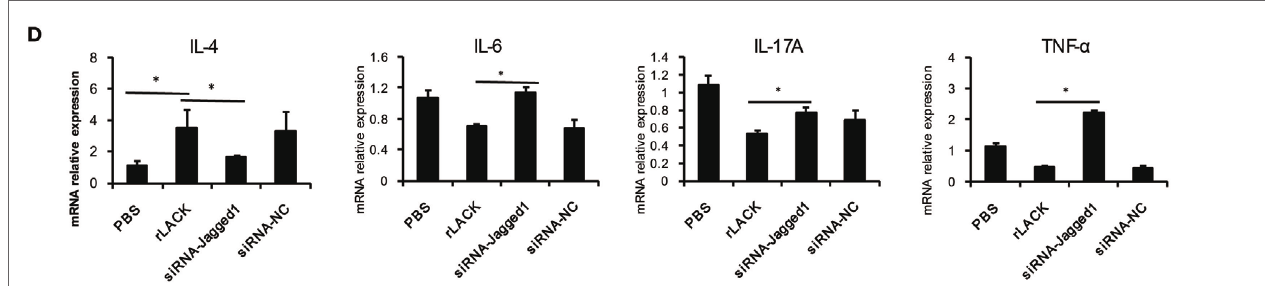
FigUre 5 | The effect of targeting Jagged1 signaling on the induction of T cell responses by LACK 156–173 epitope-stimulated dendritic cells (DCs). siRNA-modified bone marrow-derived dendritic cells (BMDCs) were co-cultured with T cells stimulated by rLACK (100 µg/µl). (a) Three siRNAs targeting different regions of Jagged1 mRNA were designed and purchased together with a scrambled siRNA to serve as a negative control. Harvested BMDCs were transfected by using Lipofectamine with three siRNAs targeting different regions of Jagged1 mRNA and a scrambled siRNA to serve as a negative control. 24 h later, we performed quantitative real-time polymerase chain reaction (qRT-PCR) to determine their Jagged1 mRNA expression in the BMDCs. (B) The purity of CD3 + CD4 + cells in isolated T cells was measured by flow cytometry. (c) The numbers of interleukin (IL)-4 + cells, IFN- γ + cells, IL-17A + cells and Foxp3 + cells in the co-culture system were examined using flow cytometry. (D) Cytokine mRNA expression was measured by qRT-PCR analysis. Dot plots are representative of one of three experiments. The results are expressed as the mean ± SEM, combined from at least three independent experiments.* p < 0.05, ** p <